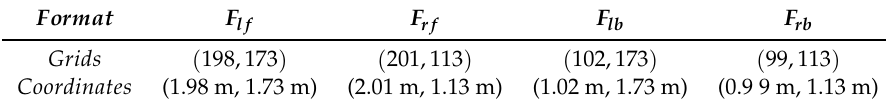
Table 6. Coordinates and grids of the default foothold in the real world.